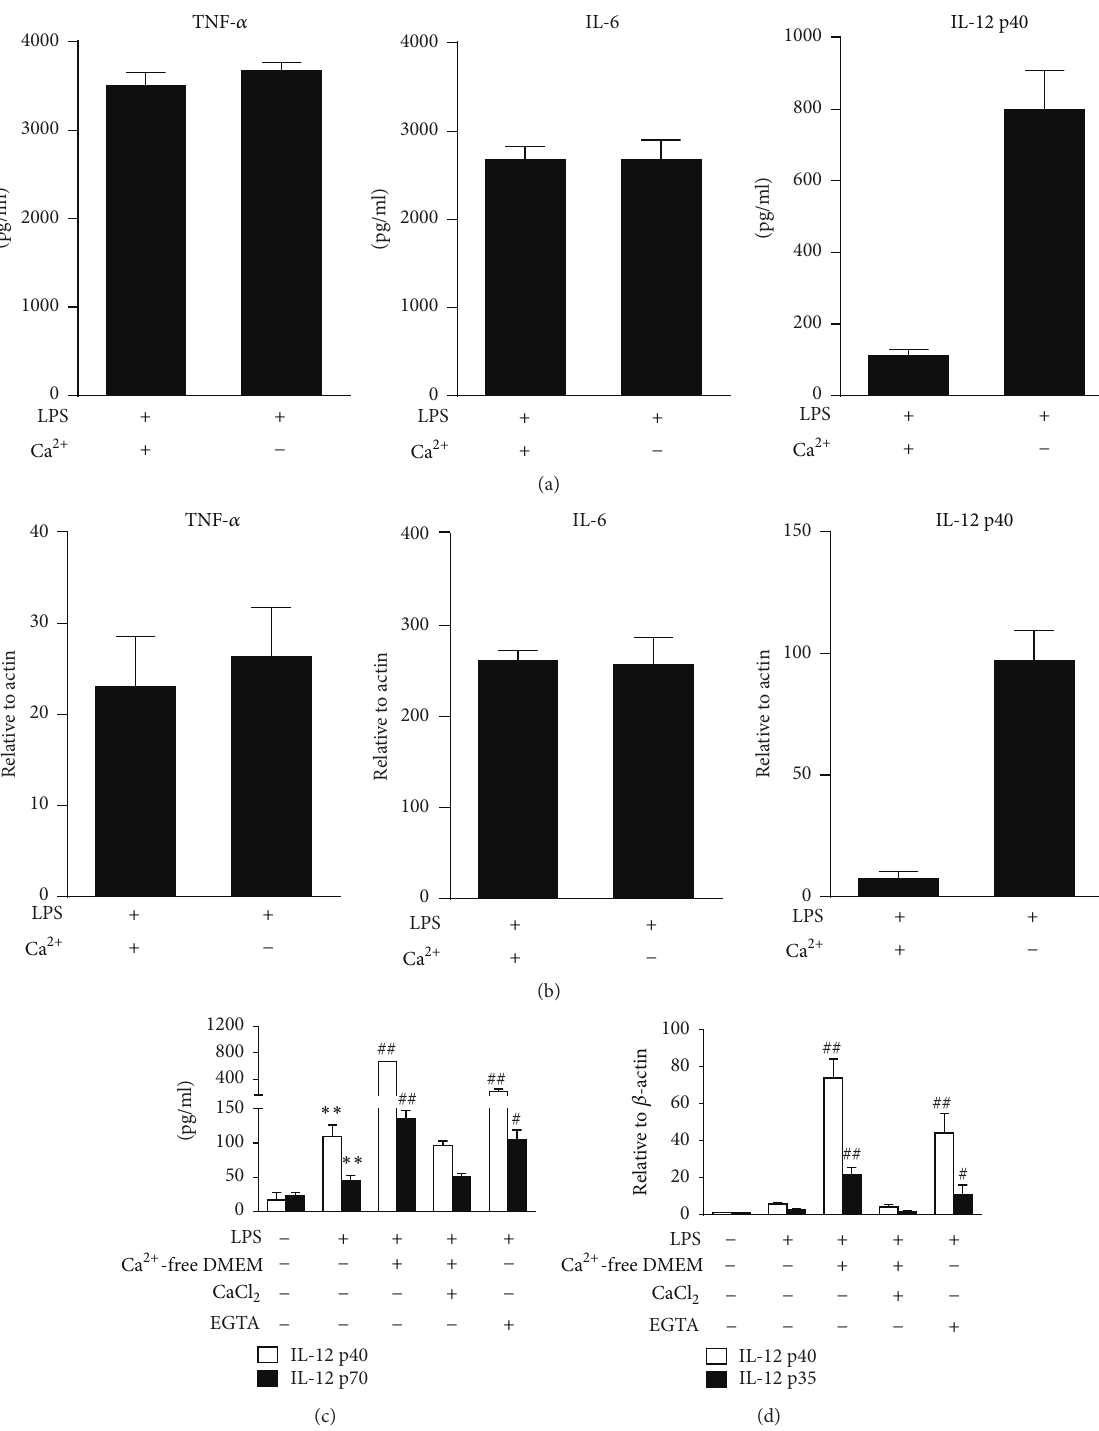
Figure 2: Depletion of extracellular calcium selectively upregulates IL-12 expression in LPS-treated murine macrophages. (a, b) Murine peritoneal macrophages cultured in DMEM with or without calcium for 1h and then stimulated with LPS (100ng/mL). Supernatants were collected after 24 h and the protein levels of TNF- 𝛼 , IL-6, and IL-12 p40 were detected by ELISA ((a) 𝑛 = 3 ). Total RNA was extracted after 12h and mRNA expressions of TNF- 𝛼 , IL-6, and IL-12 p40 were detected by real-time PCR ((b) 𝑛 = 3 ). ∗∗ 𝑃 < 0.01 versus LPS. (c, d) Murine peritoneal macrophages were incubated with LPS (100ng/mL) in normal DMEM, calcium-free DMEM, calcium-free DMEM with 2mM CaCl 2 , or normal DMEM with 5 mM EGTA. The mRNA expressions of IL-12 p40 and IL-12 p35 were detected via real-time PCR (c). The supernatant levels of IL-12 p40 and IL-12 p35 were detected via ELISA (d). ∗∗ 𝑃 < 0.01 versus medium; # 𝑃 < 0.05 and ## 𝑃 < 0.01 versus LPS ( 𝑛 = 3